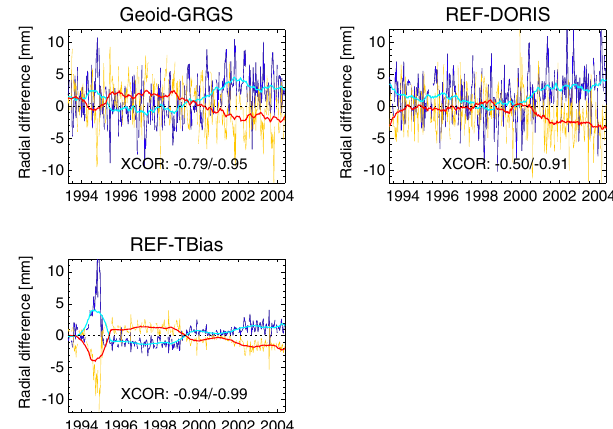
Figure A3. Global mean radial orbit differences over the oceans per cycle and 1-year box-car filtered for Geoid minus GRGS, REF mi- nus DORIS, and REF minus TBias separately for ascending (blue, cyan) and descending (yellow, red) tracks. The cross-correlation co- efficient between the ascending and descending passes for the orig- inal and the filtered series is given in the lower part of each